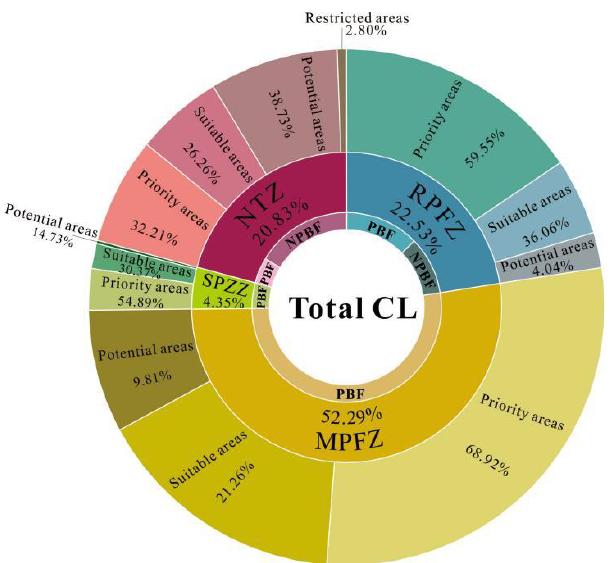
Figure 10. Composition of the two zones (NPBF is non-permanent basic farmland; NTZ is non-two zone).